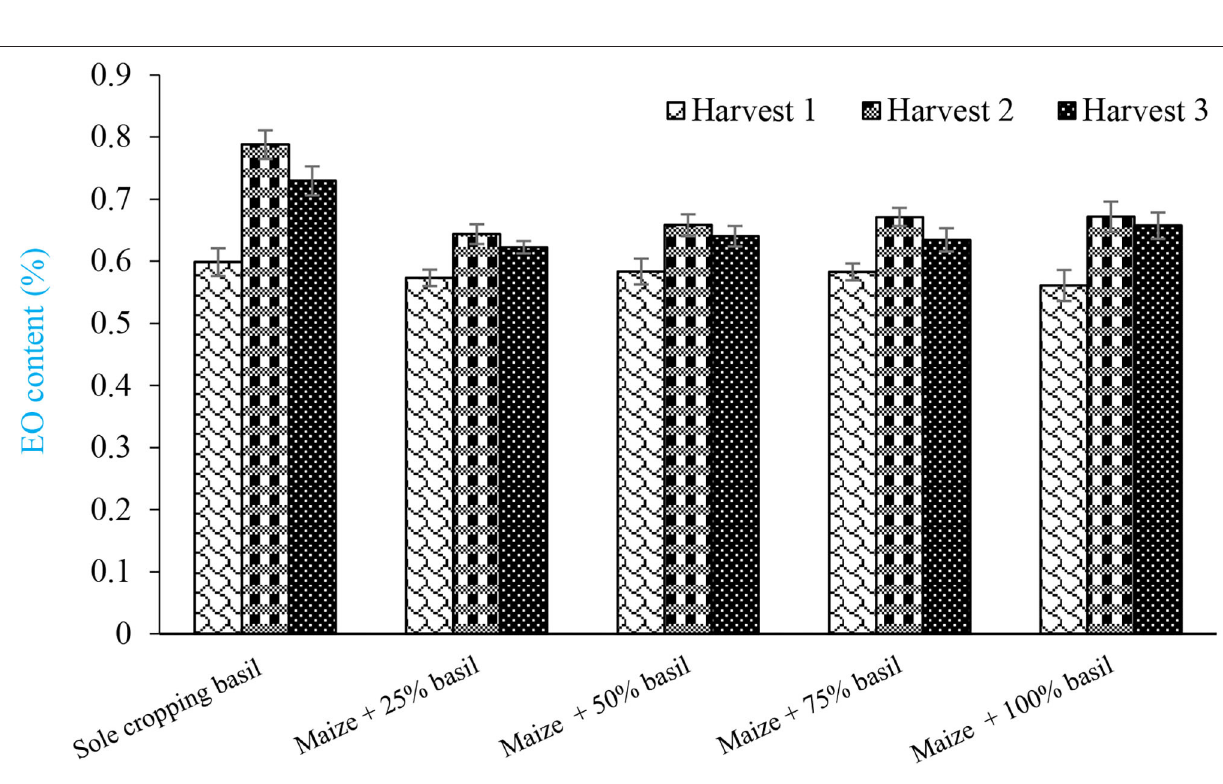
Frontiers in Plant Science |